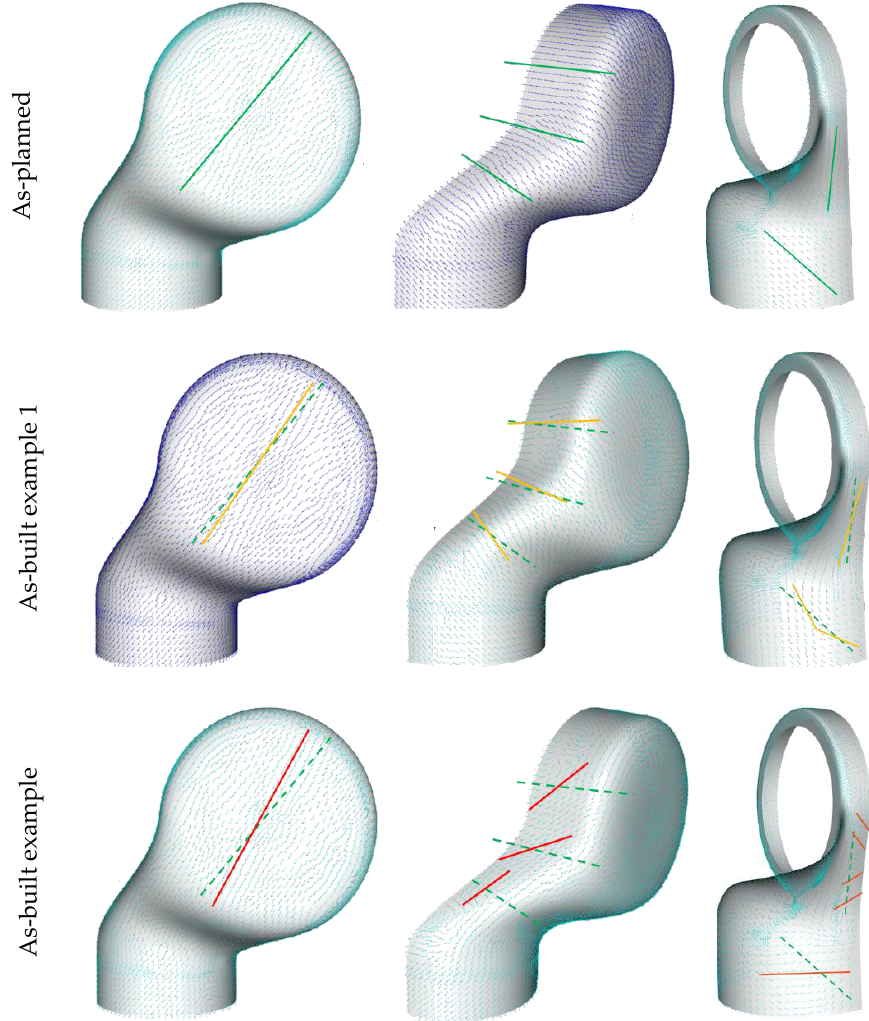
Figure 14. Comparison of the as-planned and two different as-built configurations.